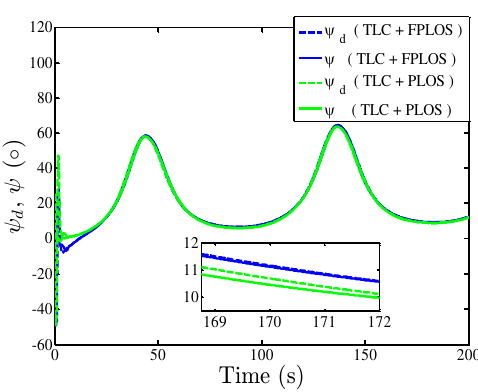
Figure 7. Guidance heading ψ d and heading ψ